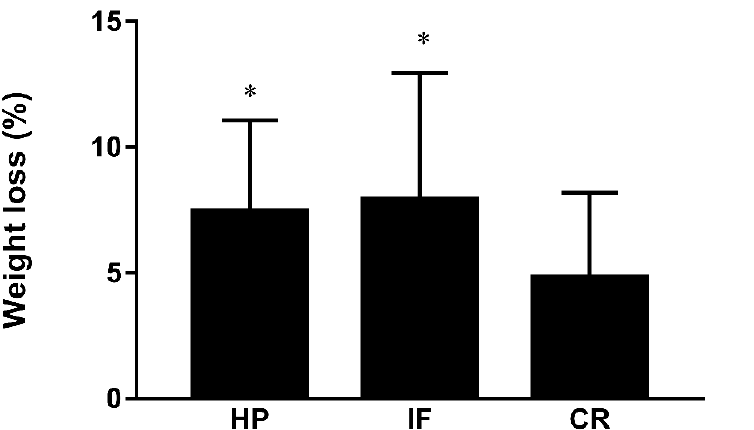
Figure 2. The differences in % total weight loss between groups. IF, Intermittent fasting 5:2 plus; CR, daily calorie restriction; HP, high protein with portion meal replacements. * p < 0.001 for difference among the three groups.